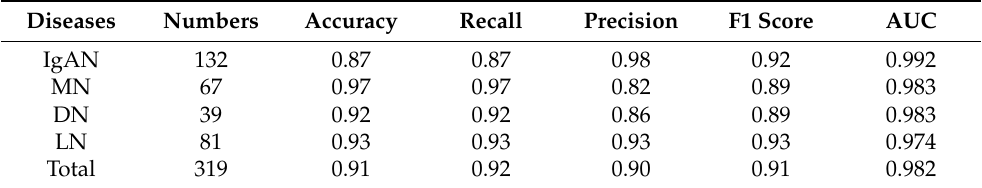
Table 2. Classification subnet performance in disease diagnosis based on blurred IF images.